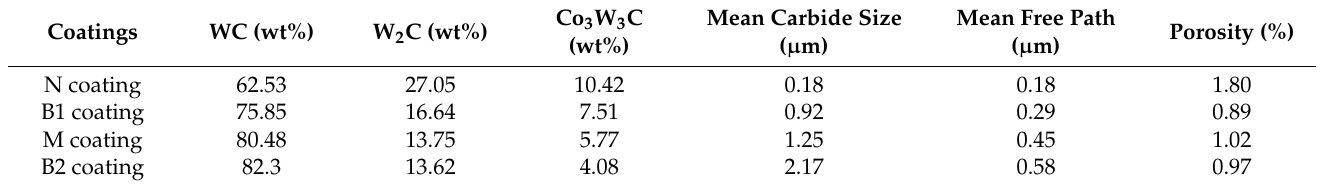
Table 3. Phase composition and microstructural parameters measured for the WC–10Co–4Cr